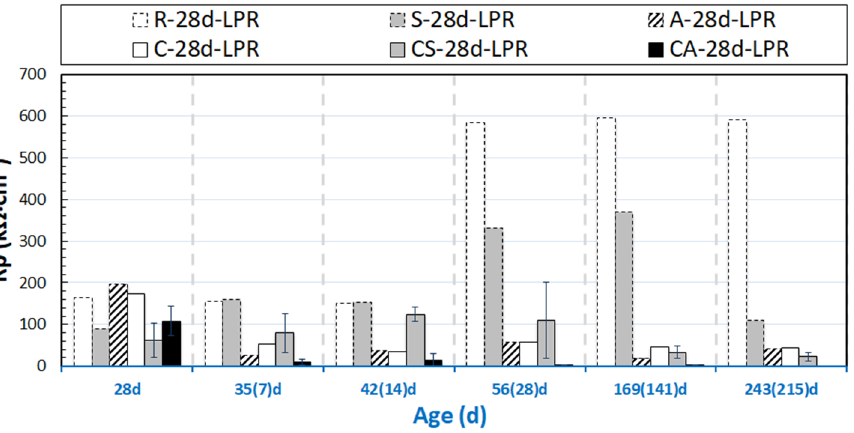
Figure 6. R p evolution of 28d-cured samples (R-28d: Reference; S-28d: Stray Current; A-28d: Anodic Polarization; C-28d: NaCl medium; CS-28d: NaCl + Stray Current; CA-28d: NaCl + Anodic Polarization); The numbers in brackets denote the conditioning duration.